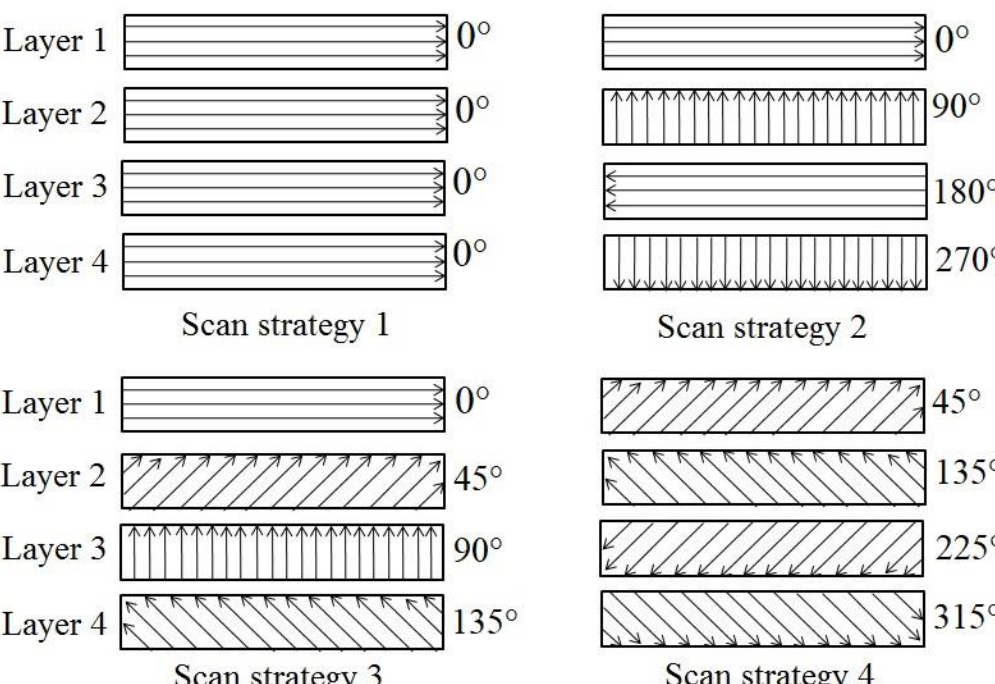
Figure 2. Scan strategies in terms of laser hatch line angles .